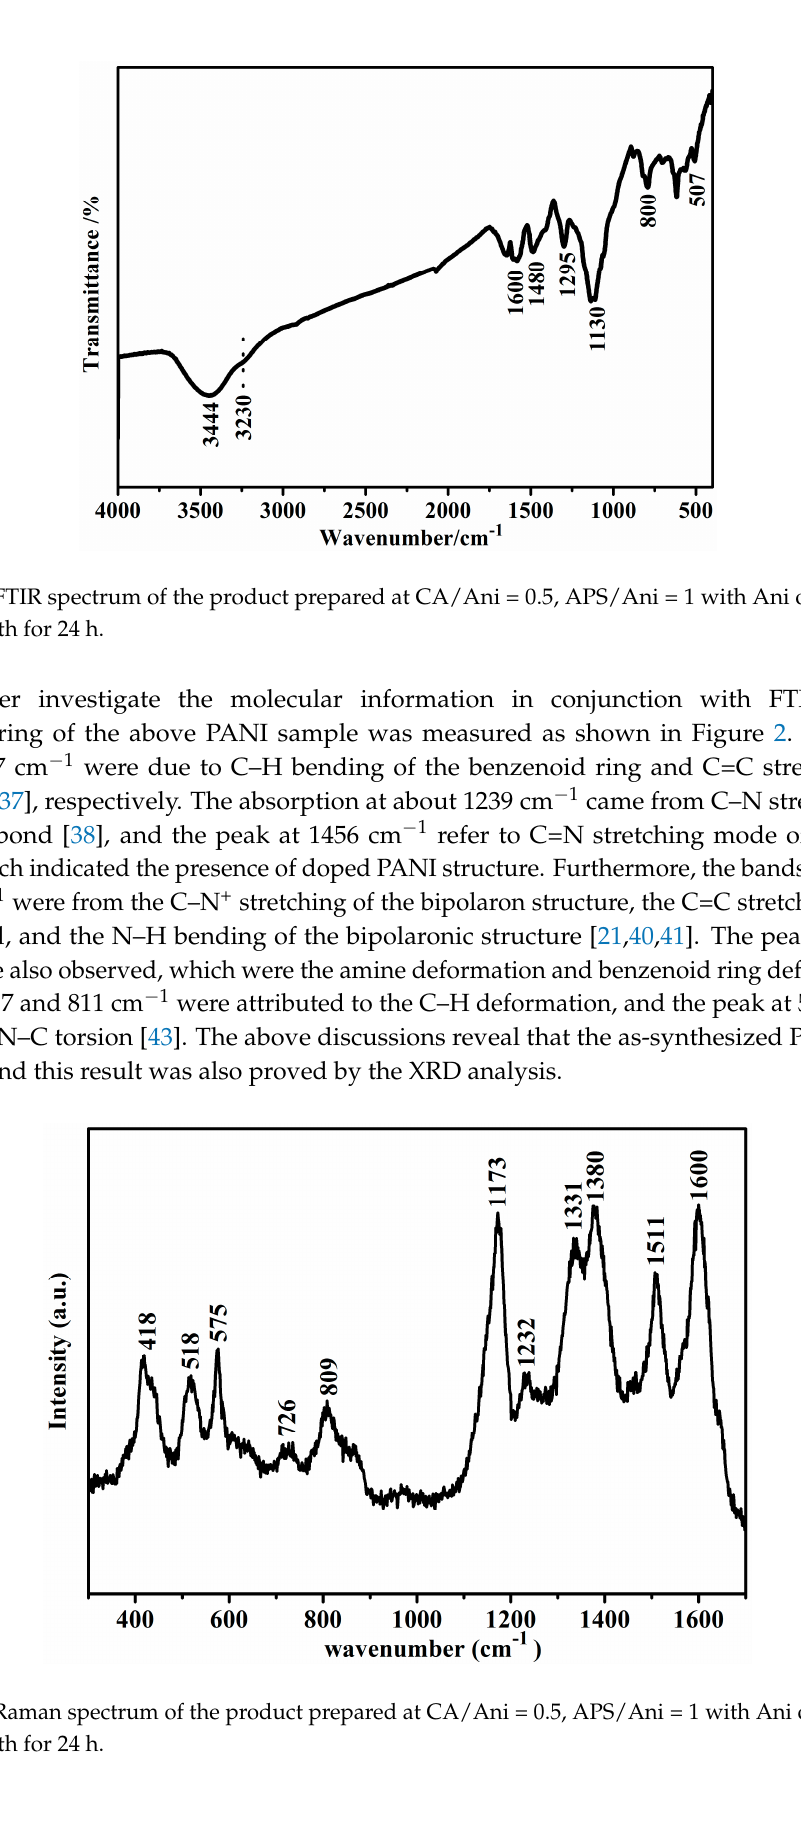
Figure 2. Raman spectrum of the product prepared at CA/Ani = 0.5, APS/Ani = 1 with Ani of 2 mmol and ice bath for 24 h.